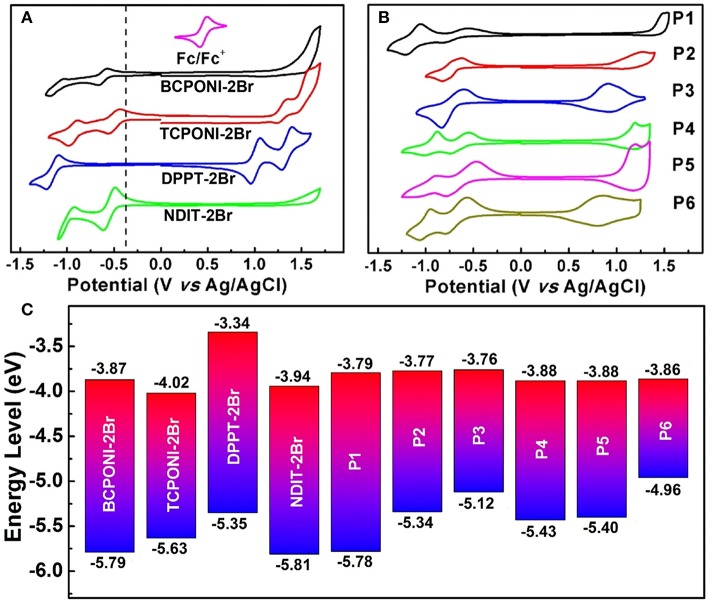
(A) CV curves of the monomers (BCPONI-2Br and TCPONI-2Br), their analogs (DPPT-2Br and NDIT-2Br). (B) CV curves of the polymers. (C) Comparative diagram for the HOMO and LUMO energy levels.